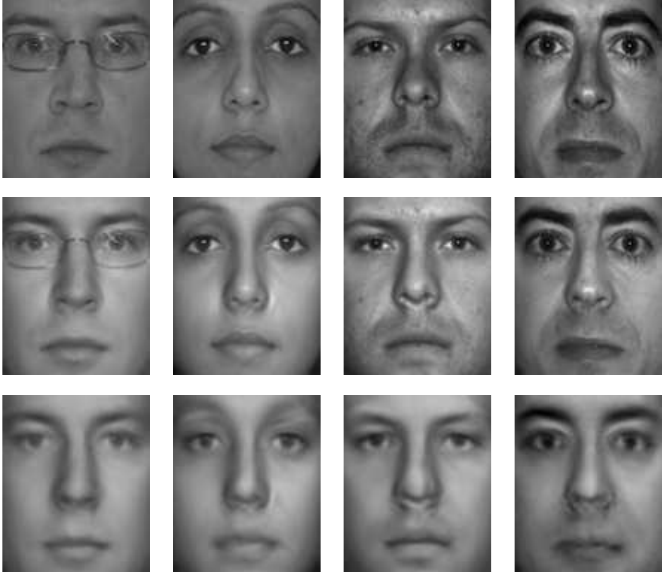
Figure 7. Comparison between the coupled bilinear model and the single image model (1st row: input image; 2nd: coupled bilinear model; and 3rd: image model only).